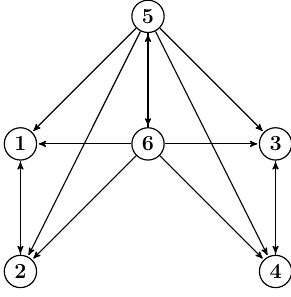
Figure 3: Weakly connected D ( w